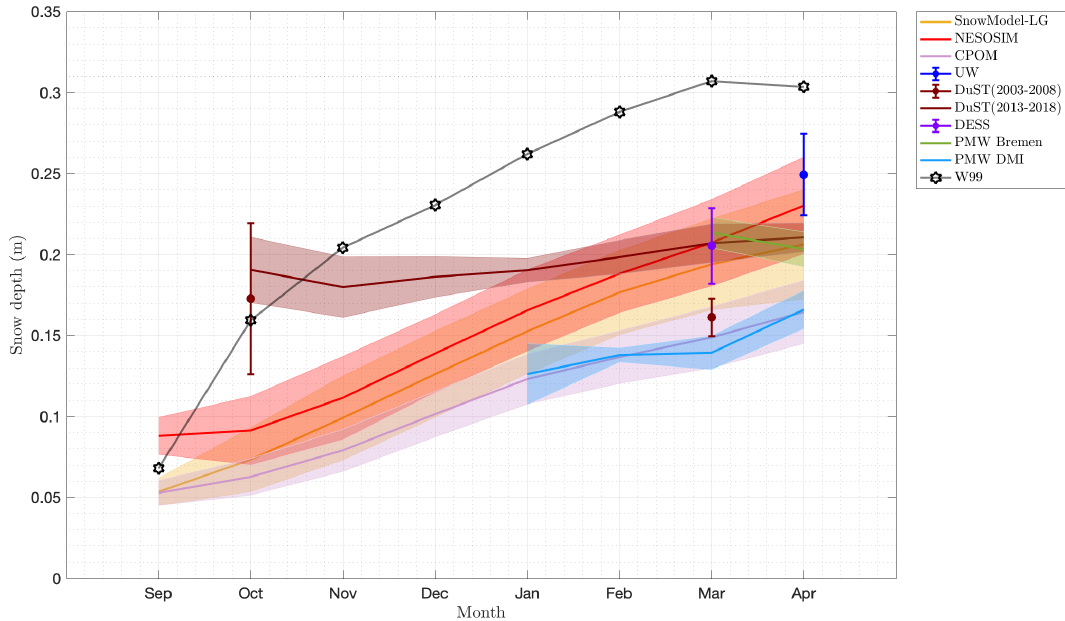
Figure 8. Wintertime snow accumulation among eight products and W 99 since 2000.